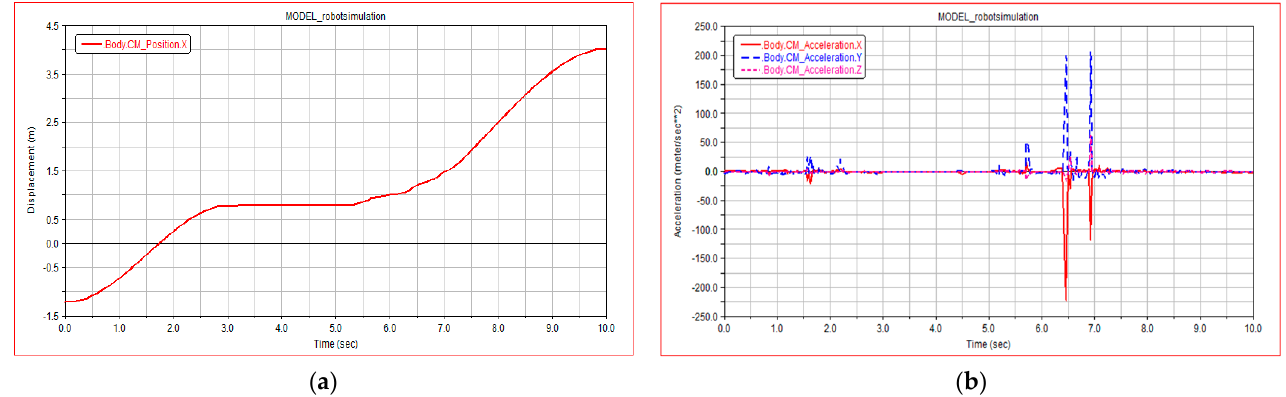
Figure 10. Simulation results of climbing stairs: ( a ) robot centroid displacement; ( b ) robot centroid acceleration.